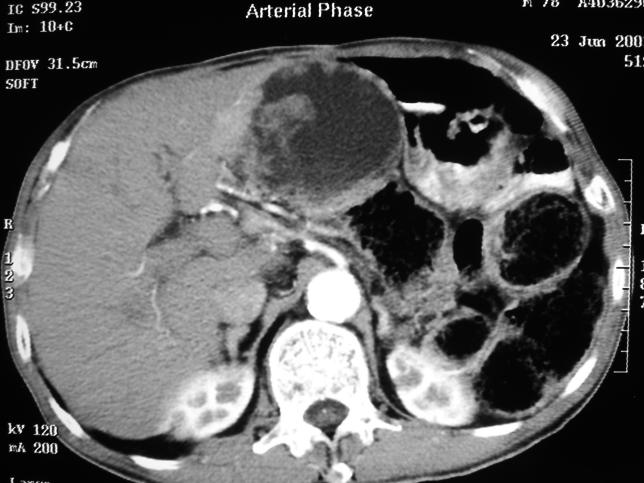
Enhanced Computed Tomography Scan of AbdomenEnhanced computed tomography scan of abdomen showing heterogenous liver metastases with irregular rim enhancement as well as hypodense lesions in the portal region suggestive of metastatic lymphadenopathy.